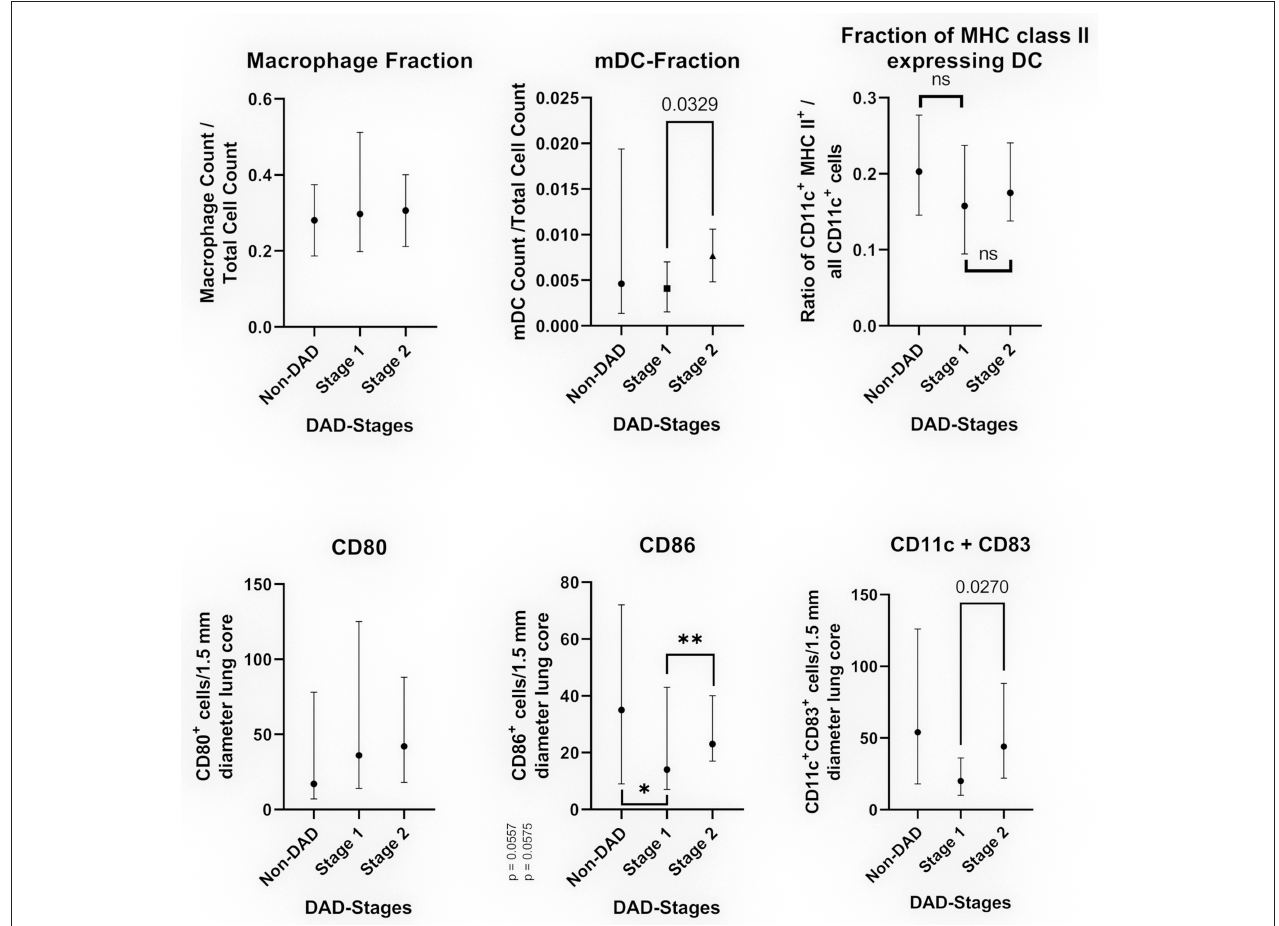
FIGURE 3 | Cell populations in relation to the DAD-Stages (median with 95% CI). The top images show the results of multiplexed immunofluorescence, while the bottom images show the results of conventional IHC. Top left: Fraction CD68/CD163 positive cells in relation to the total cell count. Top middle: Fraction of myeloid dendritic cells in relation to all counted nuclei. Top right: Fraction of myeloid dendritic cells expressing MHC class II in relation to all CD11c + cells. Bottom left: Average of CD80 + cells per 1.5mm diameter lung core. Bottom middle: Average of CD86 + cells per 1.5mm diameter lung core. The differences were non-significant for non-DAD vs. stage 1 (* p = 0.0557) and stage 1 vs. stage 2 (** p = 0.0575) by a narrow margin. Bottom right: Average of CD11c + CD83 + cells (double staining) per 1.5mm diameter lung